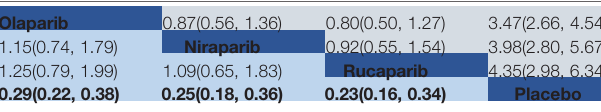
TABLE 5 | The network meta-analysis of PFS in HRD-positive patients.